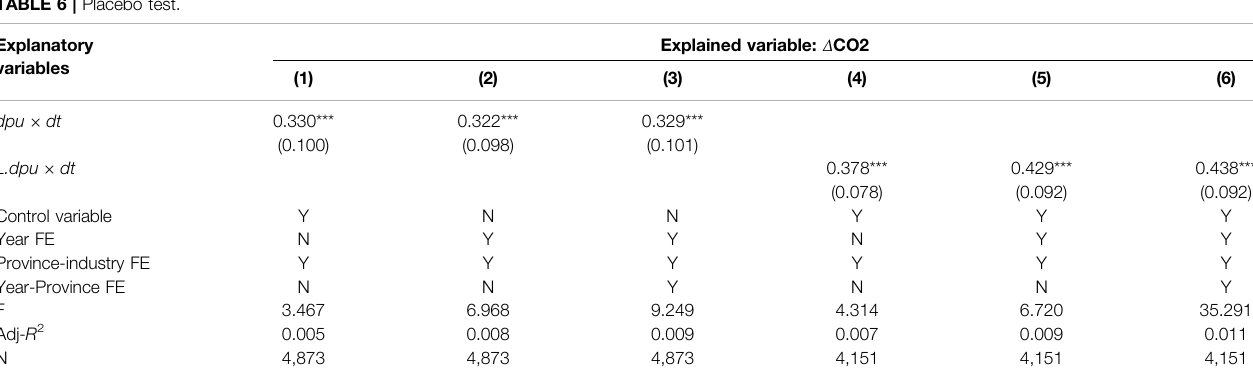
TABLE 6 | Placebo